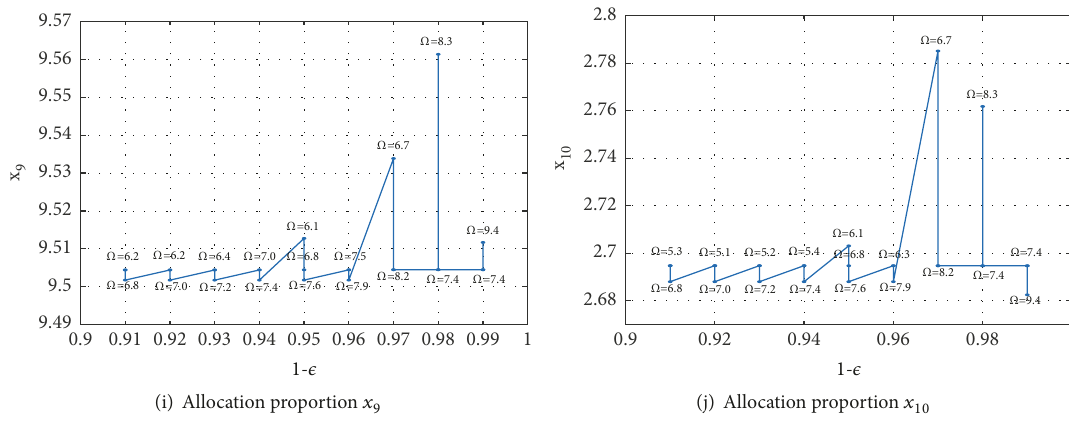
Figure 3: The variation of optimal portfolio strategies in Case I under different risks.